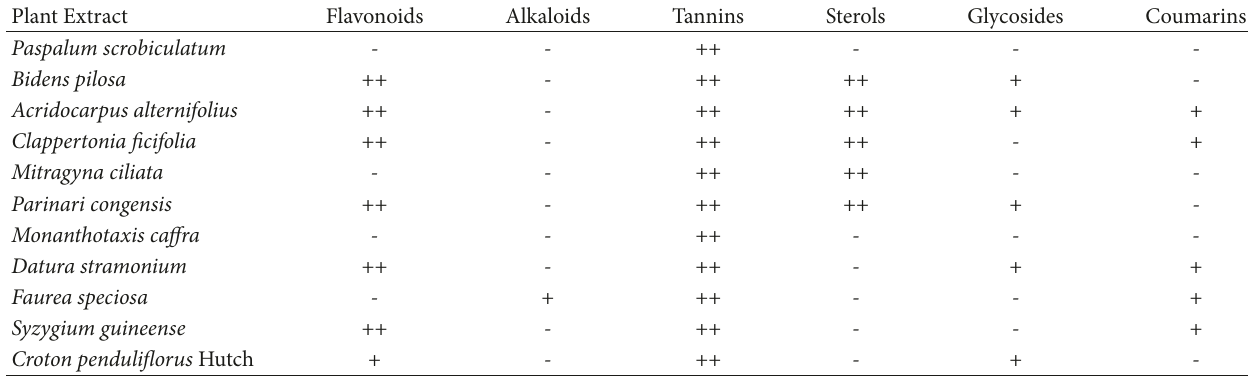
Table 2: The major phytochemicals present in the extracts of the selected plants.